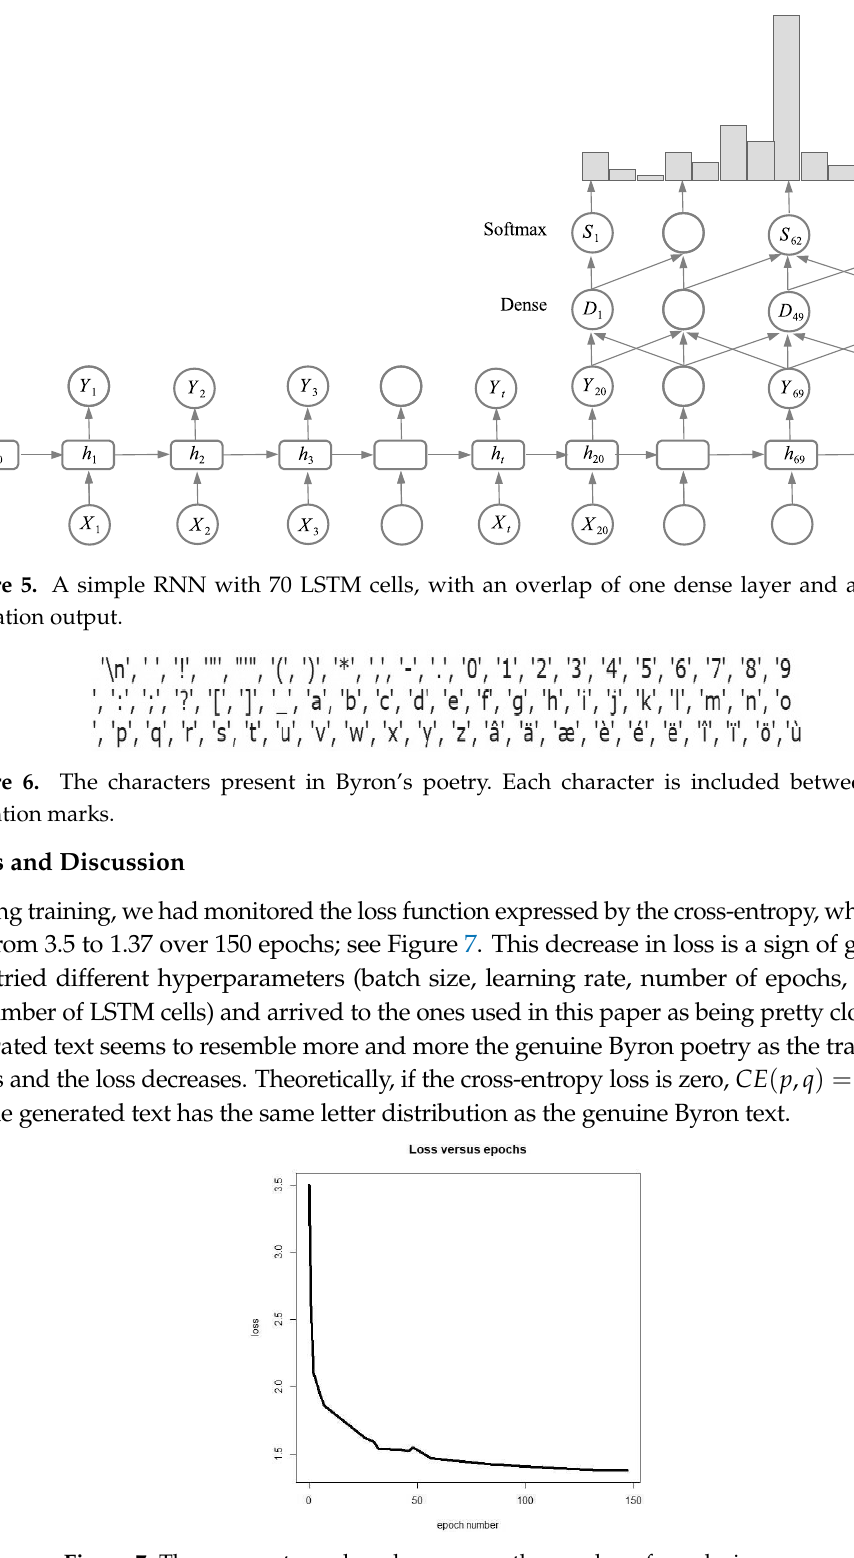
Figure 7. The cross-entropy loss decreases as the number of epochs